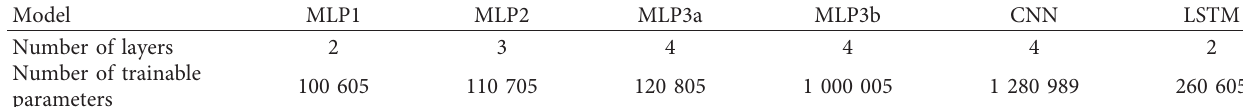
Table 4: Number of layers and number of trainable parameters for the evaluated neural network architectures.